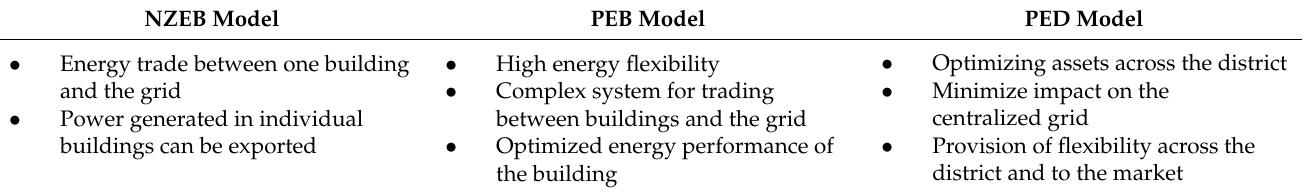
Table 1. Differences between NZEBs, PEBs and PEDs (based on